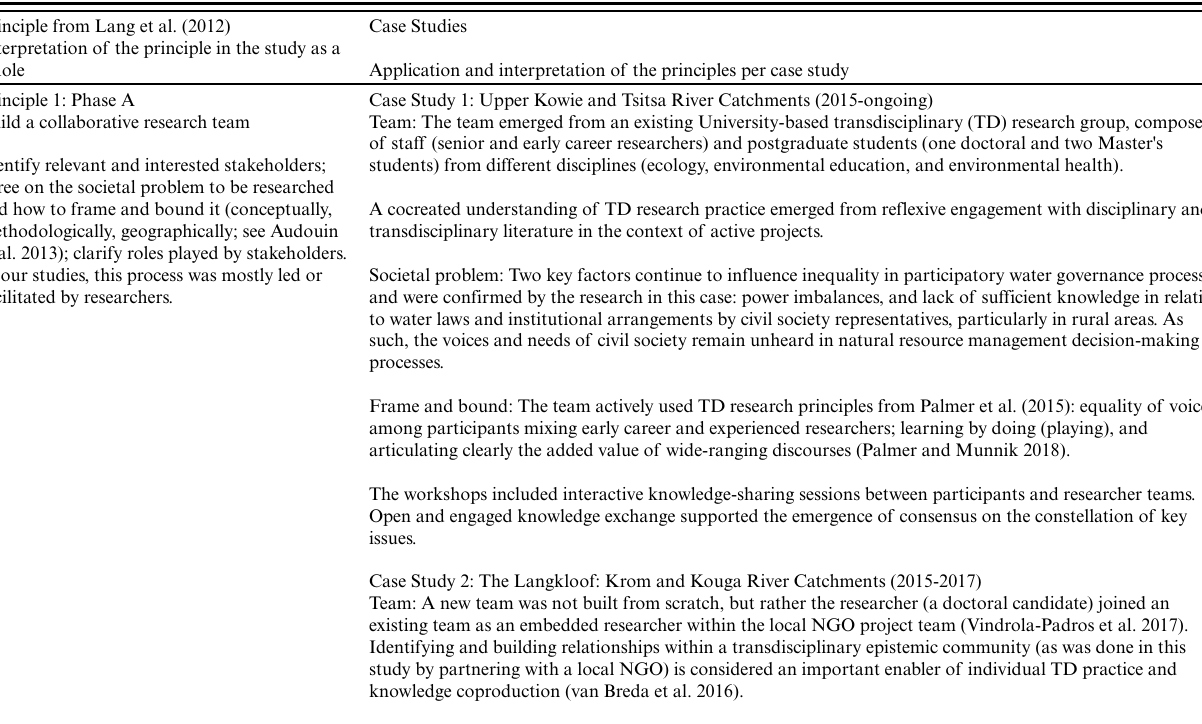
Table 2 . Design principles, interpretation, and application in each case